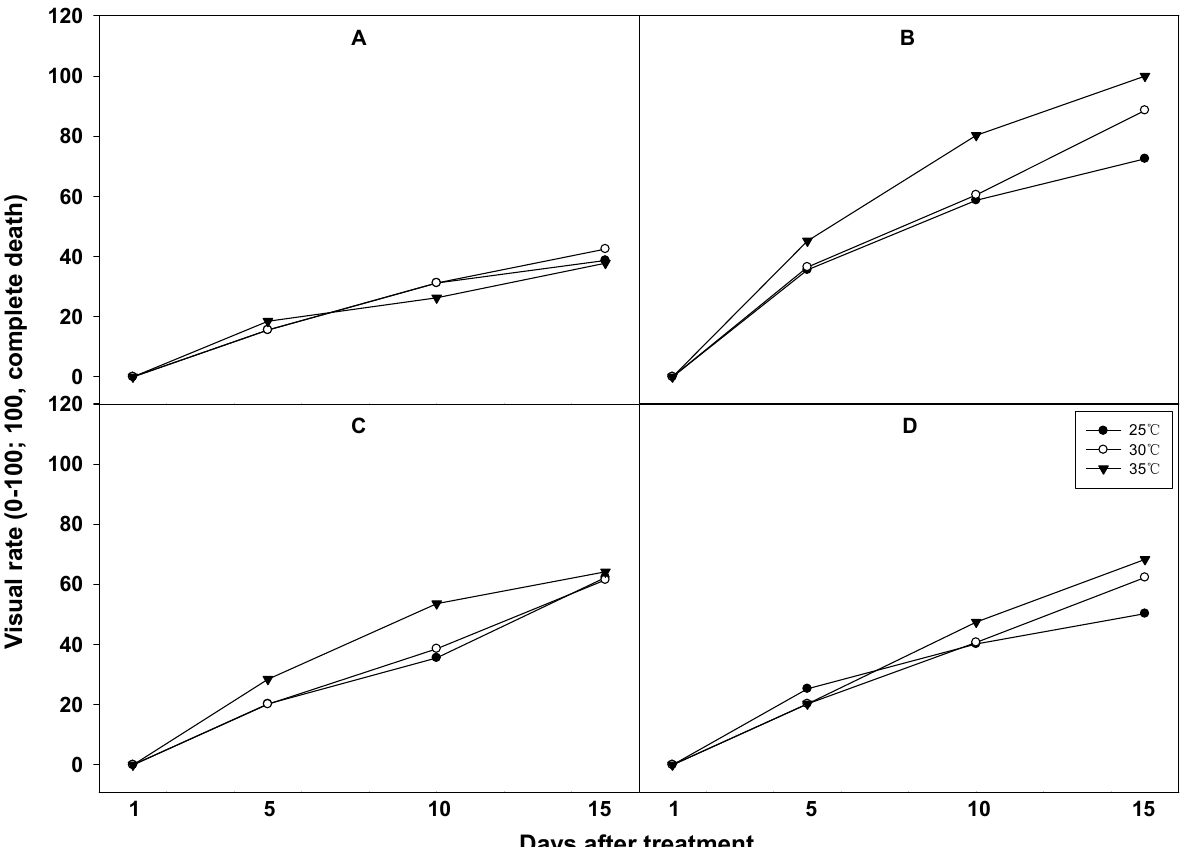
Figure 6. Visual rate (0–100, 100, complete death) of A. patulus in response to soil-applied herbicides ( A . alachlor; B . metolachlor; C . ethalfluralin; D . linuron) at each recommendation rate under different temperatures of growth chamber. The control values were low when alachlor treatments at 50% and 100% of the rec- ommended dosage were applied to A. patulus (Figure 7). Conversely, despite having low overall control values, the experiments with the highest control values were those where A. patulus was kept in a growth chamber at 30 °C. When metolachlor was applied at half the recommended dosage, the control values declined as growth chamber temperatures